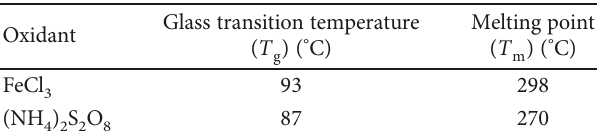
Figure 8: DSC results of PPy samples with di ff erent ferric chloride concentrations (pyrrole 0.05M and surfactant 0.025M at 25 ° C and duration 4 h). Table 2: DSC glass transition and melting temperature results for two